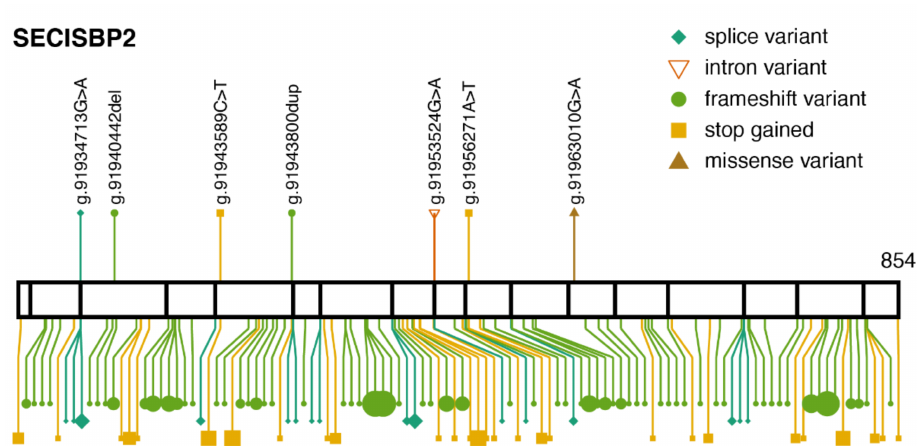
Figure 5. Pathogenic variants and protein-truncating variants in SECISBP2. Location of ClinVar pathogenic variants (above) and gnomAD protein-truncating variants (below), along the SECISBP2 protein sequence. The same aesthetics as Figure 1b are used. SECISBP2 transcript: